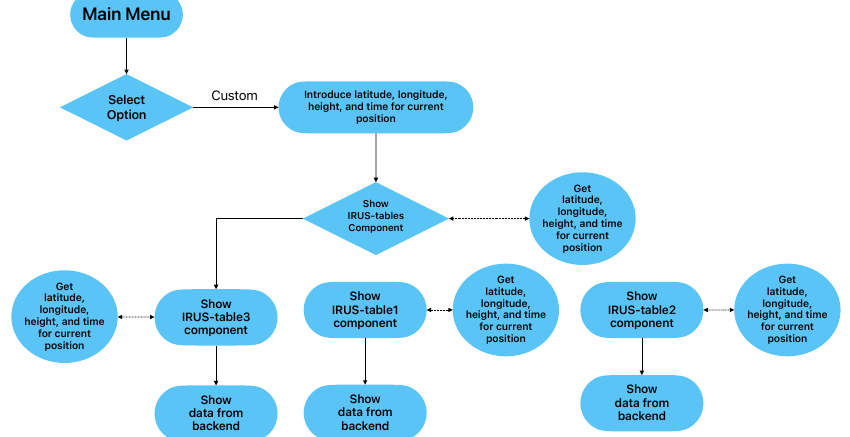
Figure 3. Workflow of the application for custom menu selection.